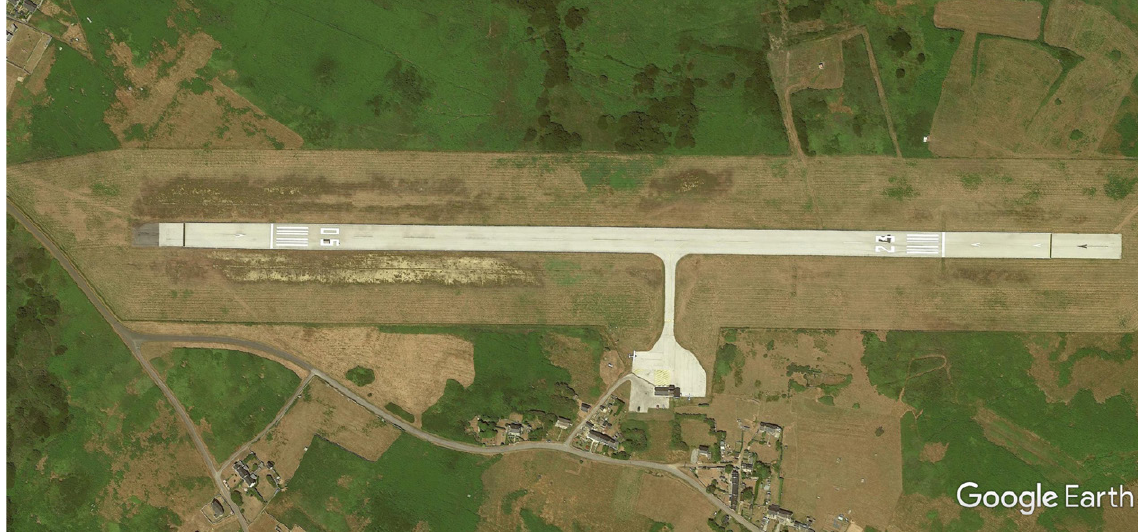
Figure 2. Aerial view of Ouessant airport. The runway is non-precision instrument runway. There is no approach light system, but low intensity edge lights and a PAPI. Strip width is 75 m